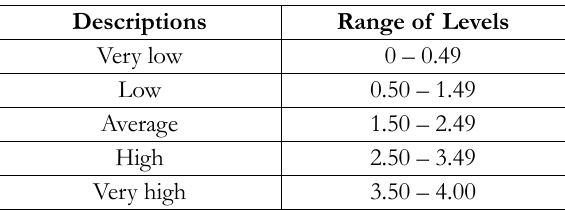
Table 1. Level of Problem Solving Skills